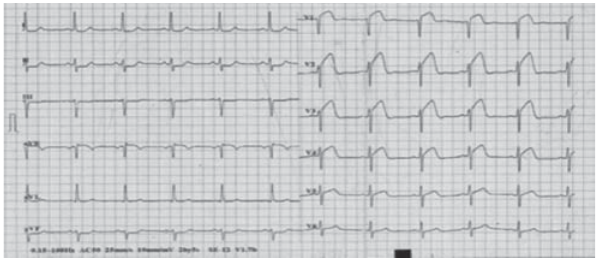
Fig 1. Initial ECG after